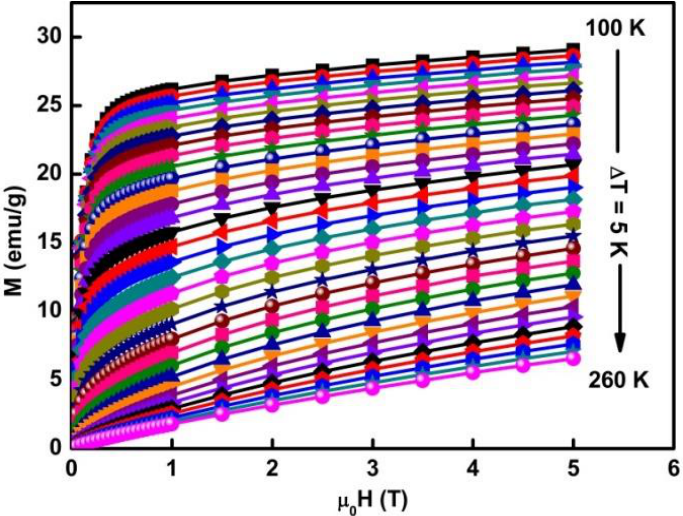
Figure 4. Isothermal magnetization around T A c at different temperatures from 100 to 260 K (increments of 5 K).